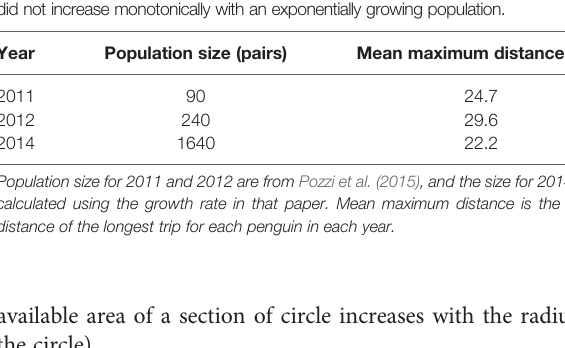
TABLE 4 | Foraging distance of Magellanic penguins tracked at El Pedral, Argentina, did not increase monotonically with an exponentially growing population. Year Population size (pairs)